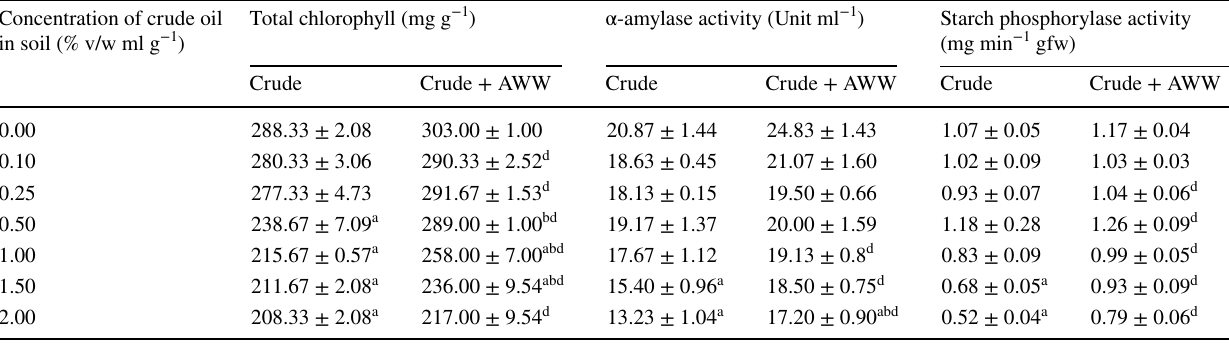
Table 3 Effect of abattoir wastewater on the content of chlorophyll, α-amylase and starch phosphorylase in cowpea seedlings exposed to crude oil polluted soil